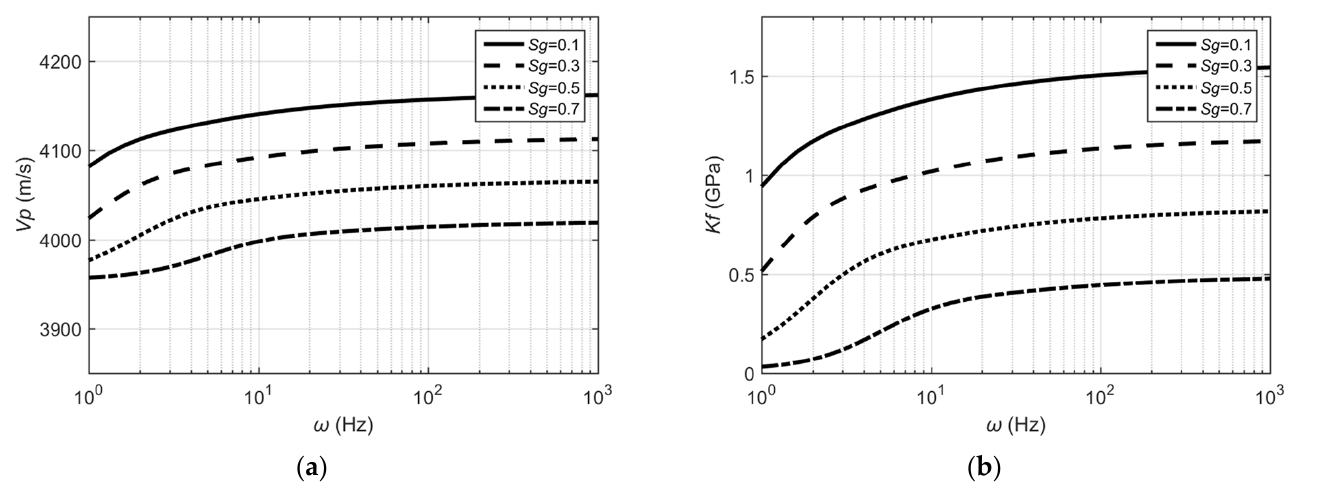
Figure 3. Computed ( a ) V P and ( b ) K f varying with frequency for different S g . The reflectivity terms of Δ V P / V P and Δ K f / K f versus frequency for different S g values were computed for an interface model separating mudstone and tight sandstone (Figure